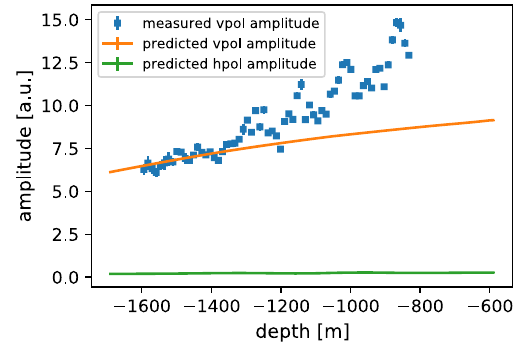
Fig. 10 The amplitude of the vpol and hpol component of the pulses reaching the ARA A5 station from different depths. The measured vpol data is indicated in blue and the normalized vpol predictions from the birefringence model are indicated in orange. ARA datapoints are pub- lished in